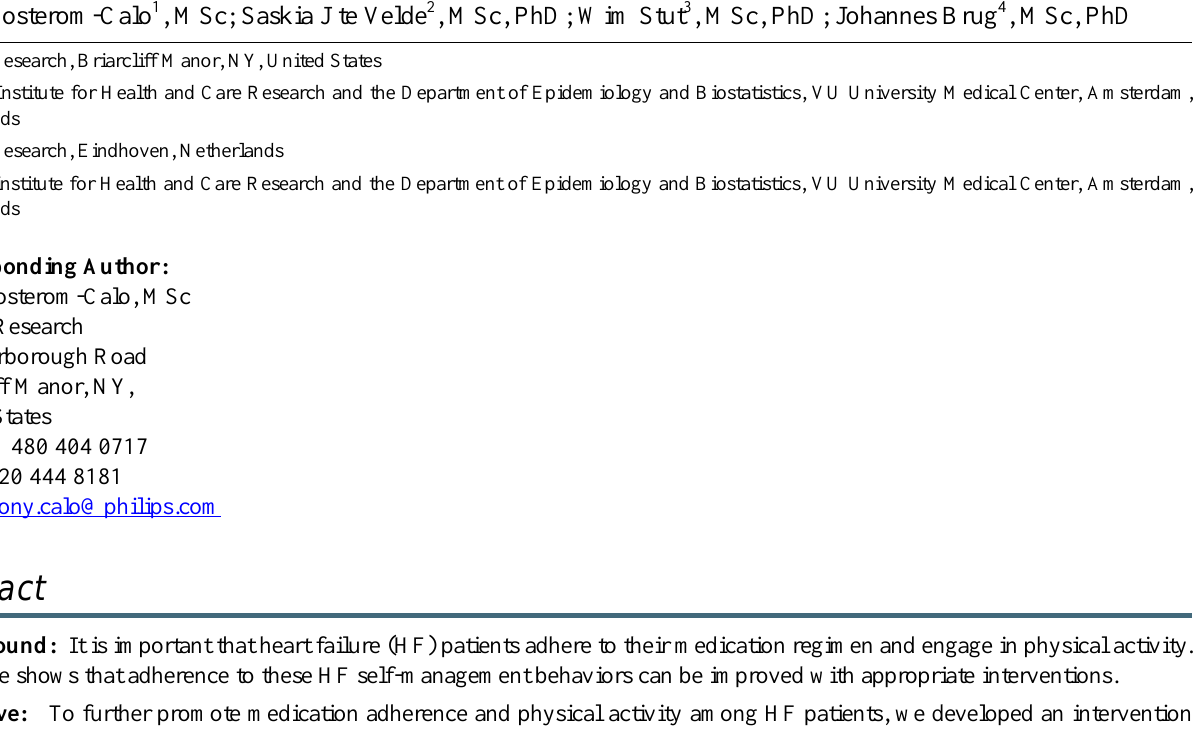
heart failure; self-care; self-management; interactive technology; medication adherence; physical activity; computer tailoring; intervention mapping;